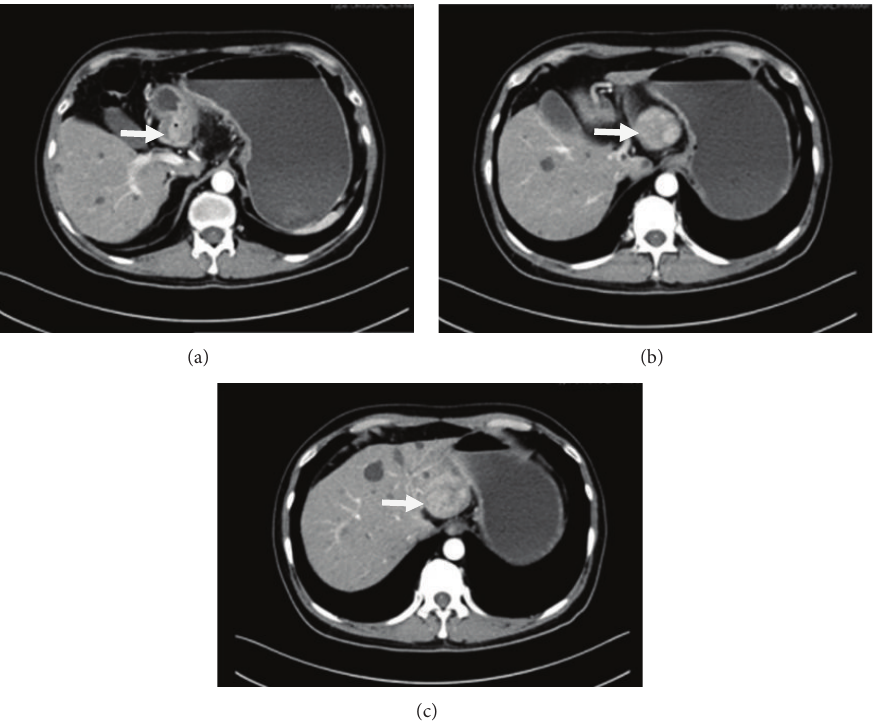
Figure 2: An irregularly thickened and rigid wall of gastric antrum which was able to be enhanced; a mass in the left hepatic lobe, which was measured 5.0 × 4.4 cm and could be partially